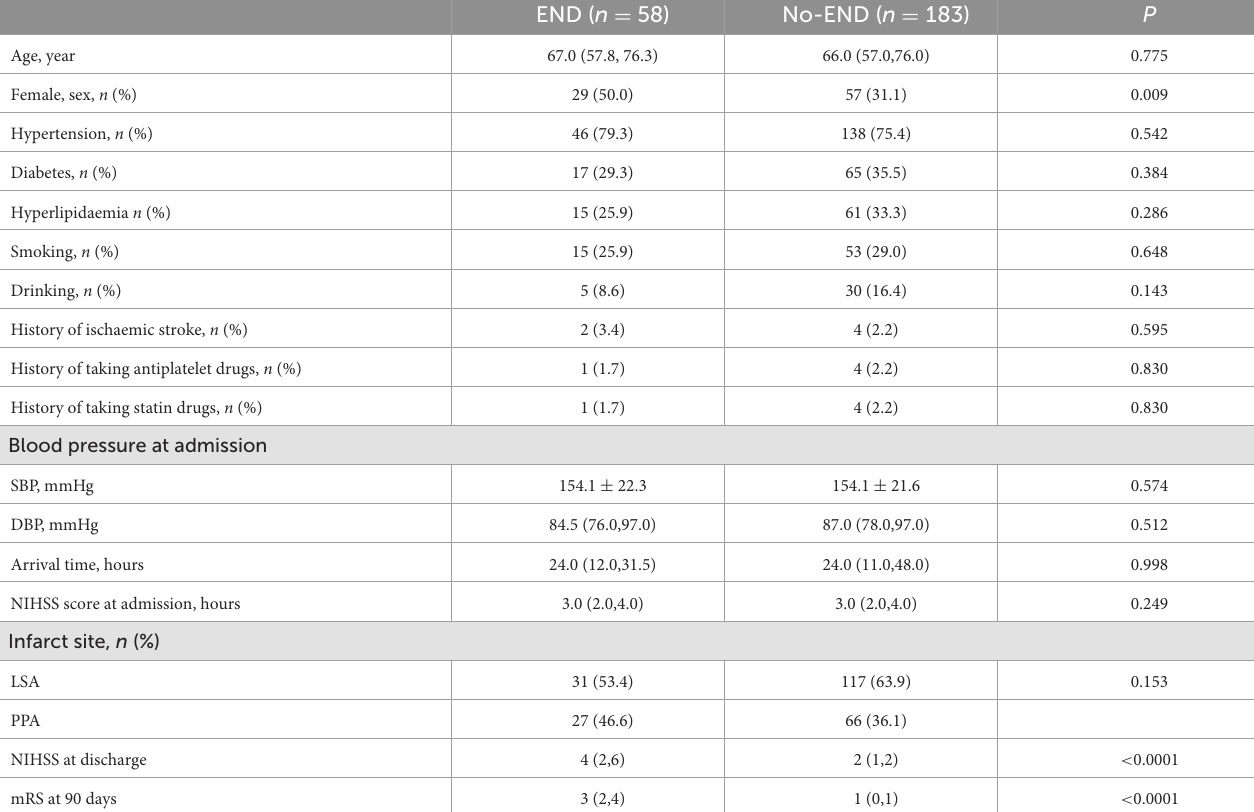
TABLE 1 The baseline characteristics of the patients with END and the No-END group.